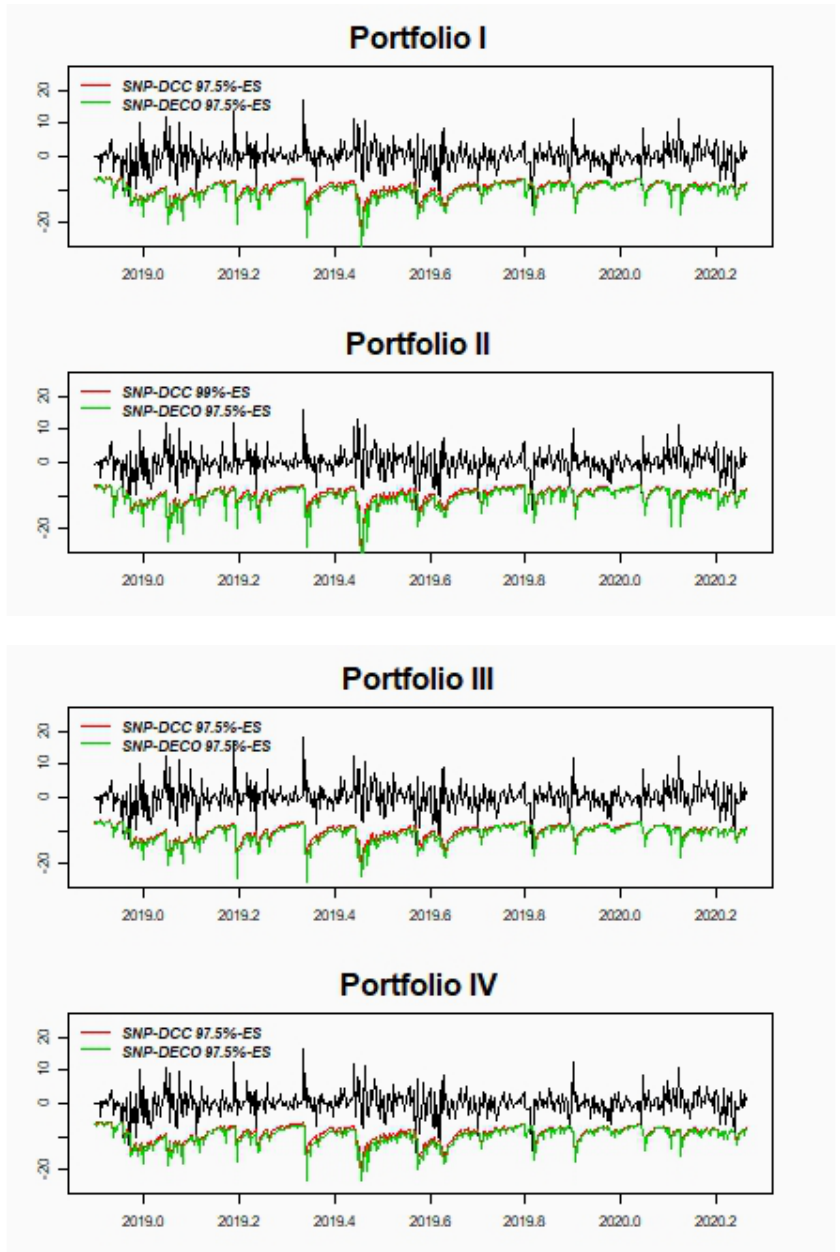
Figure 4. Portfolio returns (black line) compared to 97.5% expected shortfall (ES) for four portfolios with both DCC (red line) and DECO (green line). Portfolio I corresponds to equally weighted portfolio; Portfolio II is 25% Bitcoin (BTC), 25% Litecoin (LTC), and 50% Ripple (XRP); Portfolio III is 25% BTC, 50% LTC, and 25% XRP; and Portfolio IV is 50% BTC, 25% LTC, and 25% XRP.